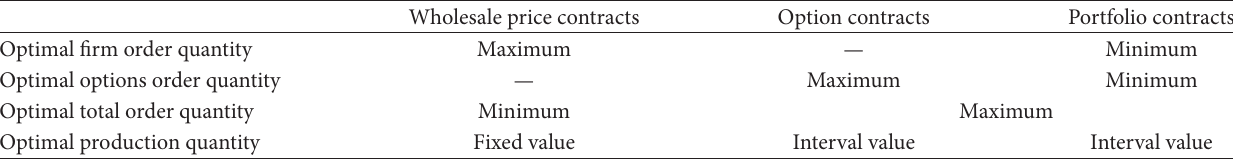
Table 1: The impact of option contracts on supply chain